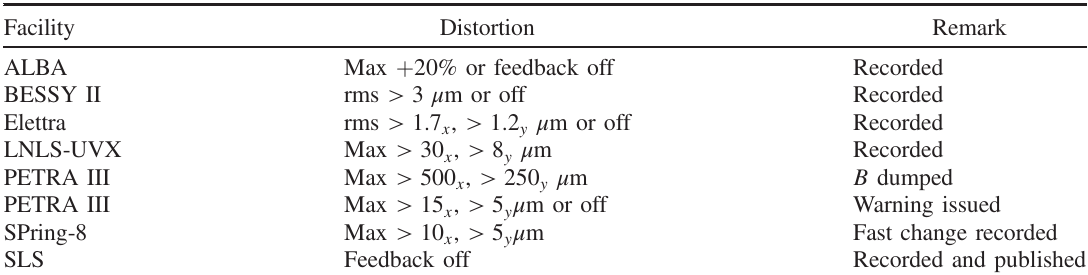
TABLE IV. Distorted-orbit failure mode for different facilities, covering orbit feedback outages and deviations from the nominal orbit.